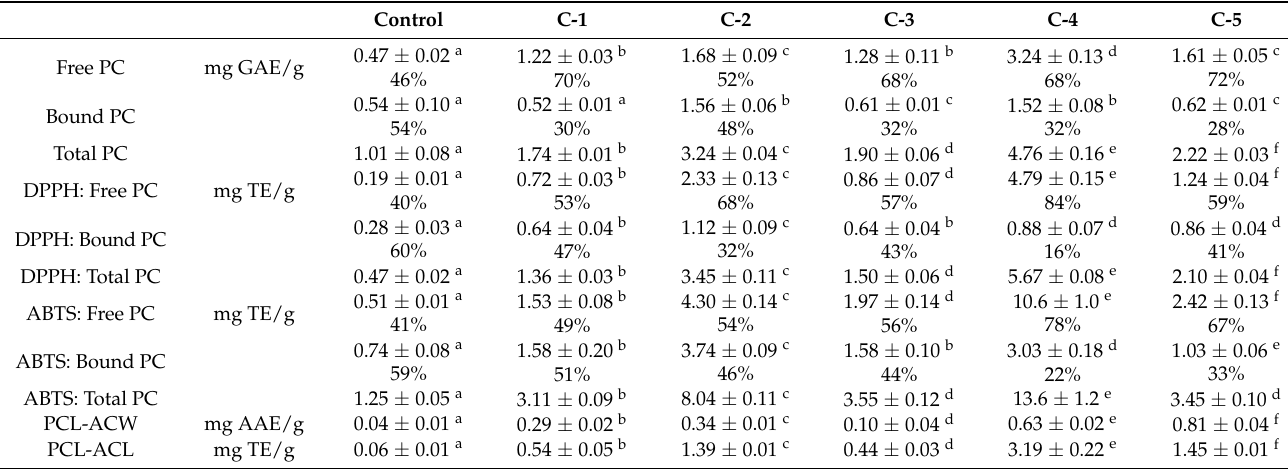
Results are presented on dry weight basis as mean ± SD ( n = 5). Values followed by the different letters in the same line are significantly different ( p < 0.05). The percentage contributions of free and bound fractions to the total phenolic contents or to the total antioxidant activities are presented. PCL-ACW: antioxidant activity of water-soluble compounds measured using PCL method; PCL-ACL: antioxidant activity of lipid soluble compounds measured using PCL method.